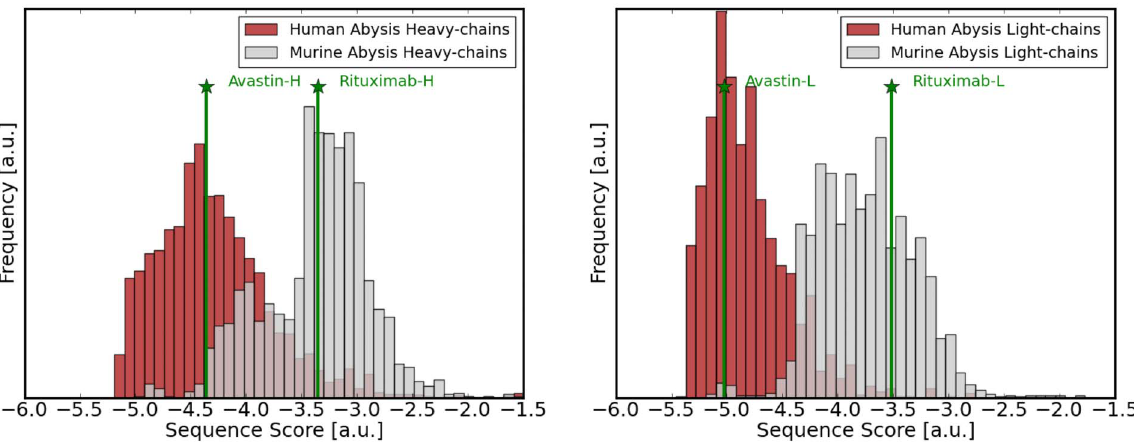
Figure 1. Comparison of human and murine sequences. Histograms of statistical sequence scores calculated for human (red) and murine (grey) sequences. Left: Heavy chains (F Hh ). Right: Light chains (F Kh ). Scores for Rituximab, a chimeric antibody, and Avastin(Bevacizumab), a humanized antibody are indicated by green lines/stars.